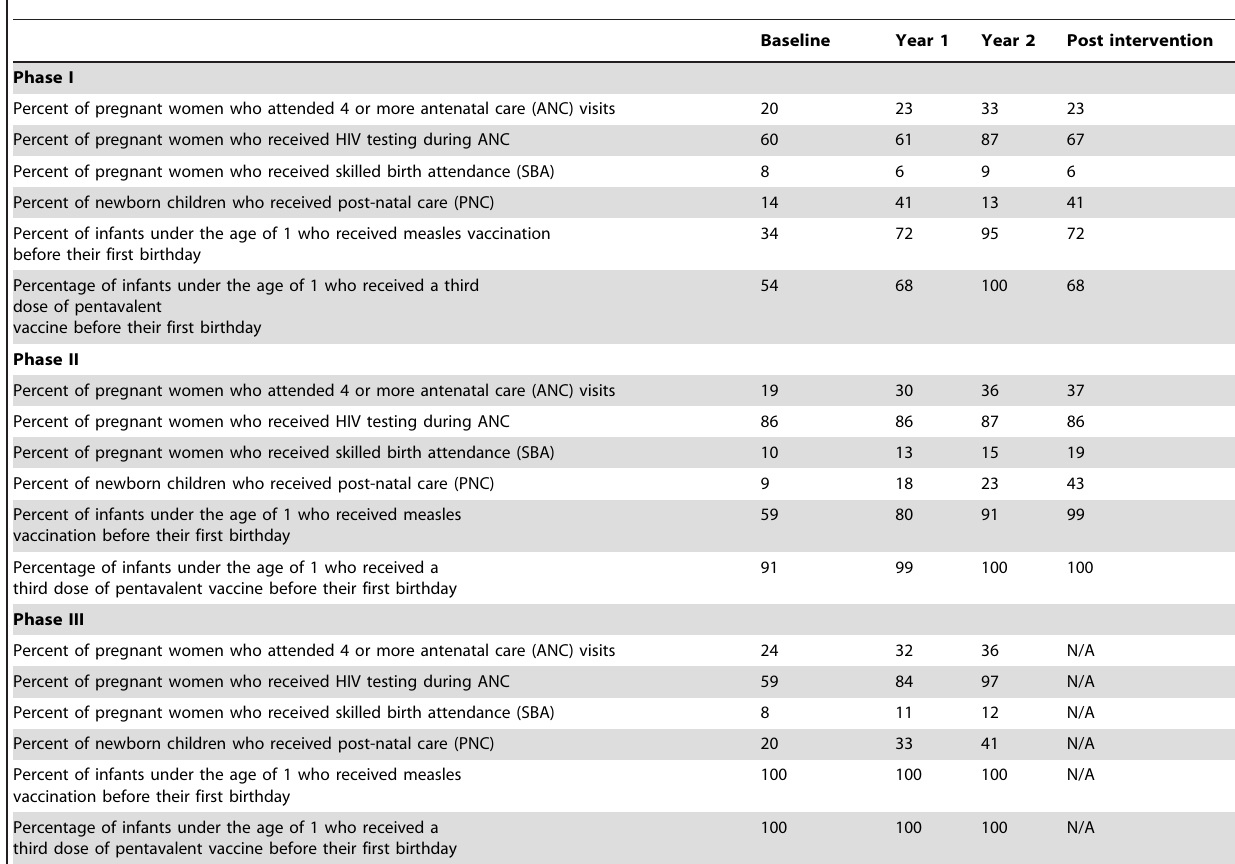
Table 2. Inputs to the Lives Saved Tool (LiST) Model (Expressed as a